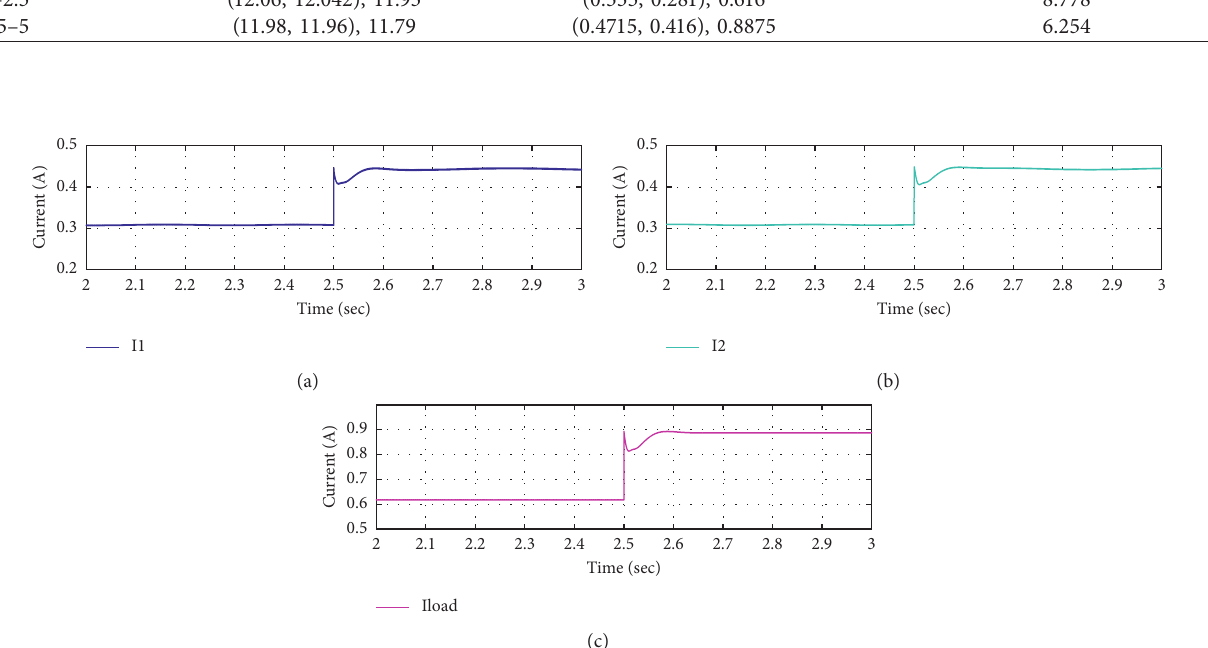
Figure 10: Simulation results for the proposed algorithm with an increase in the load. (a) Output current of converter I. (b) Output current of converter II. (c) Total load current.